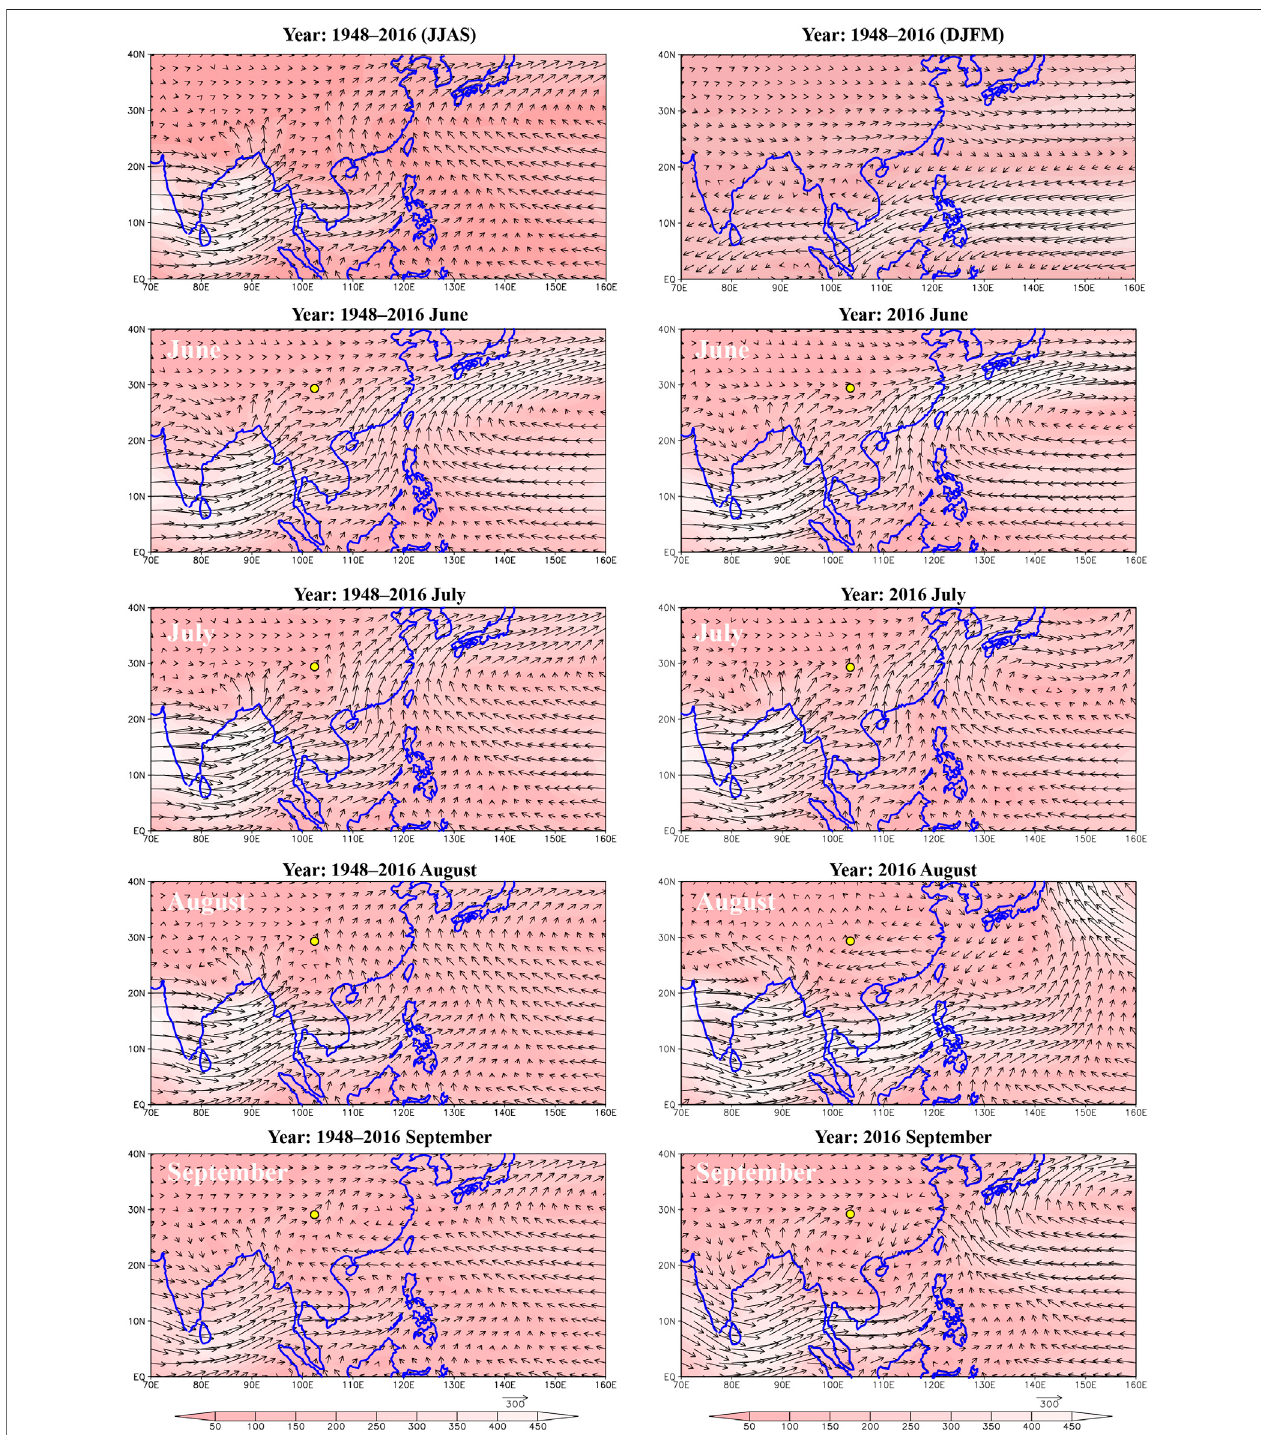
FIGURE 4 | Moisture fl uxes (kg m − 1 s − 1 ) integrated from 1,000 to 300 hPa during the wet season and dry season in 1948 – 2016 average, and comparisons of monthly moisture fl uxes in wet seasons between 1948 and 2016a and 2016, respectively. Moisture fl uxes (kg m − 1 s − 1 ) and geopotential heights (gpm) are based on the monthly reanalysis data from the National Center for Environmental Prediction (NCEP) and the National Center for Atmospheric Research (NCAR).